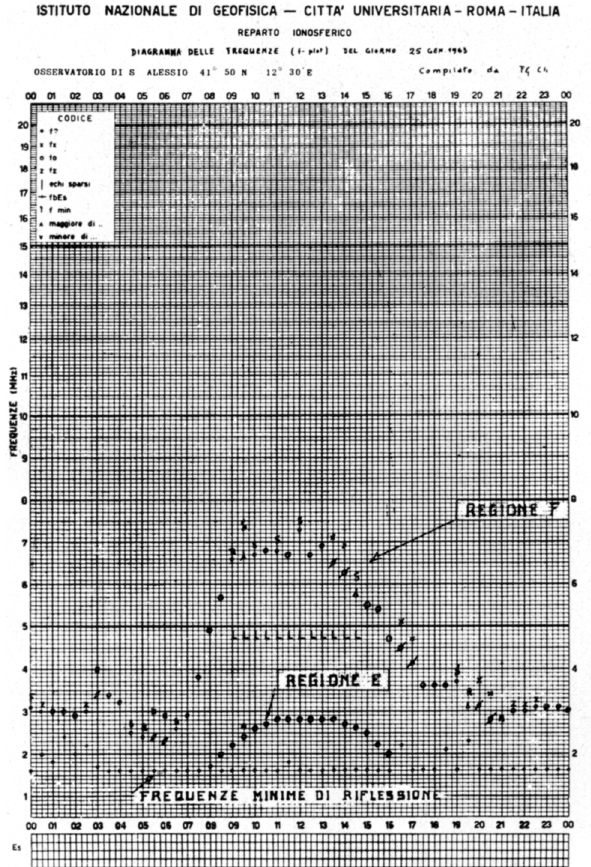
Fig. 5. Daily diagrams of the critical frequencies recorded on January, 25 1963 (from: Istituto Nazionale di Geo- fisica,